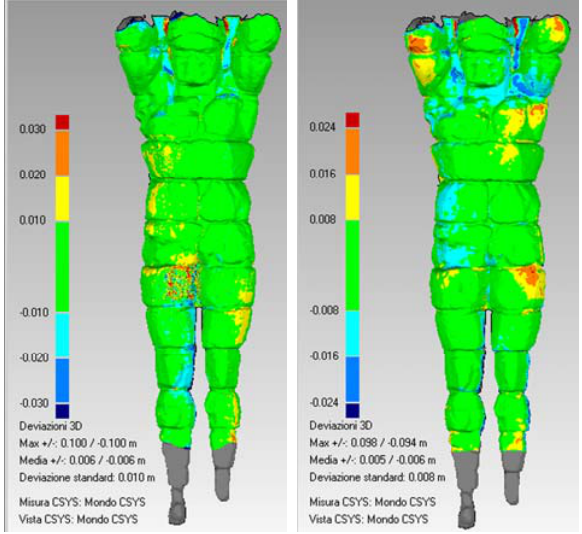
Figure 14. Colour-coded mapping of the comparison between Laser Scanner 3D Model and ZScan 3D Model (on the left), Image Master 3D Model (on the